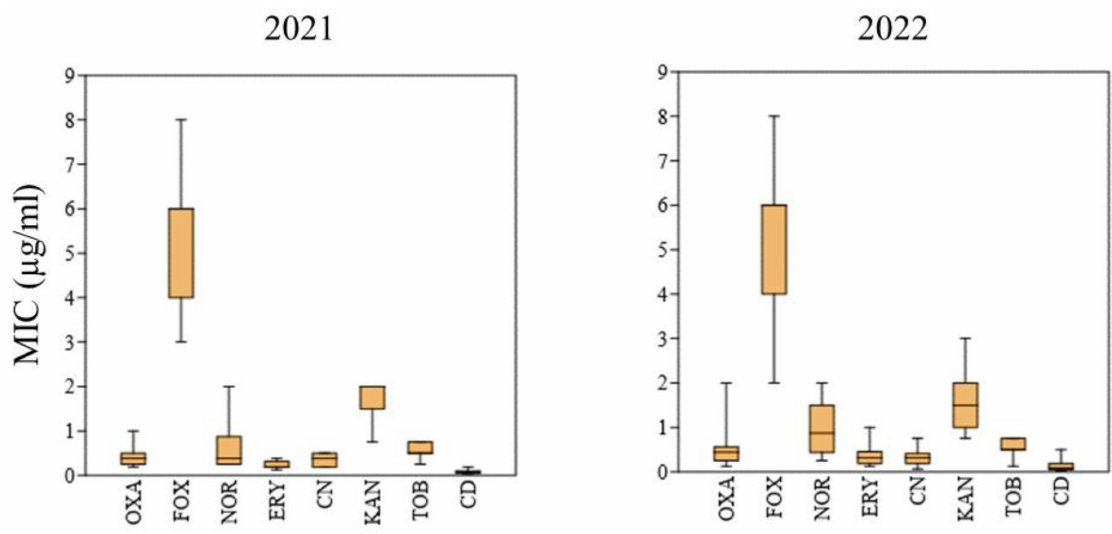
Figure 2. Distribution of MIC values for oxacillin (OXA), cefoxitin (FOX), norfloxacin (NOR), ery- thromycin (ERY), gentamicin (CN), kanamycin (KAN), tobramycin (TOB) and clindamycin (CD) in the years 2021 and